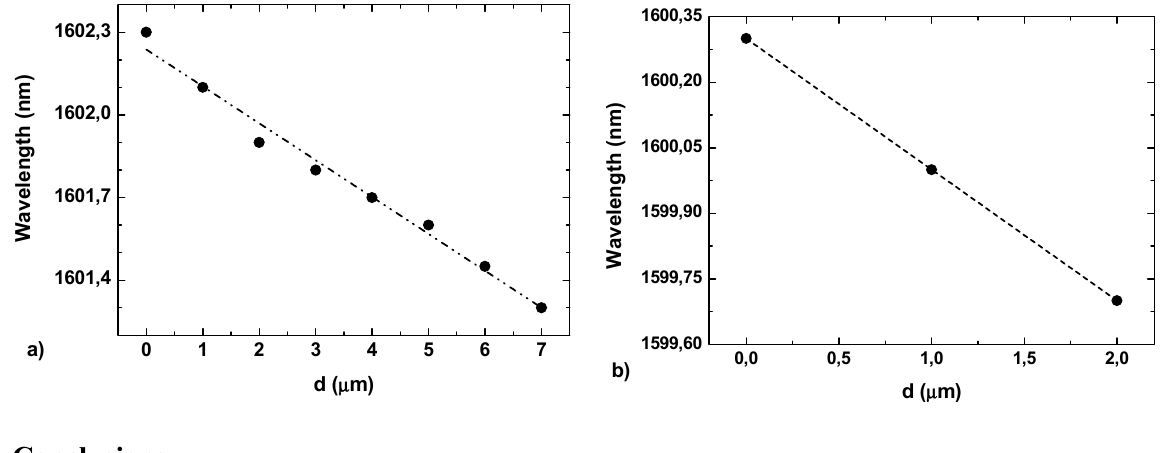
Figure 5. Wavelength response of the sensor for displacement changes, for sensor cavity length of ( a ) 2.5 cm and ( b ) 1.25